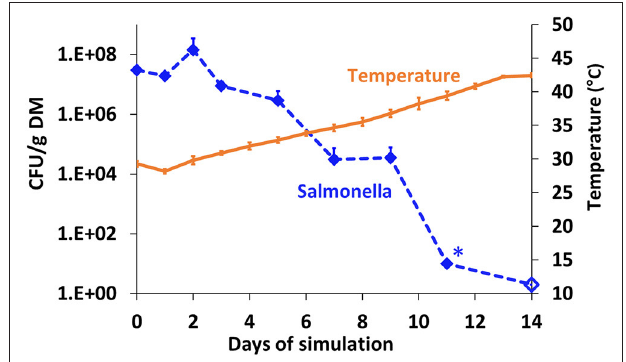
FIGURE 4 | Persistence of S . Infantis in broiler litter (BL) during controlled anaerobic simulation in duplicate reactors maintained at mesophilic temperatures. The BL was pre-adjusted to a water content of 40% and initial pH 7, and the temperature increased to 42 ◦ C over a period of 14 days. Error bars represent the standard deviations of two reactors. Empty symbols indicate a value below the detection limit after enrichment (1–2 CFU g − 1 dry matter); *values below the detection limit without enrichment (10–20 CFU g − 1 dry matter). DM, dry matter.